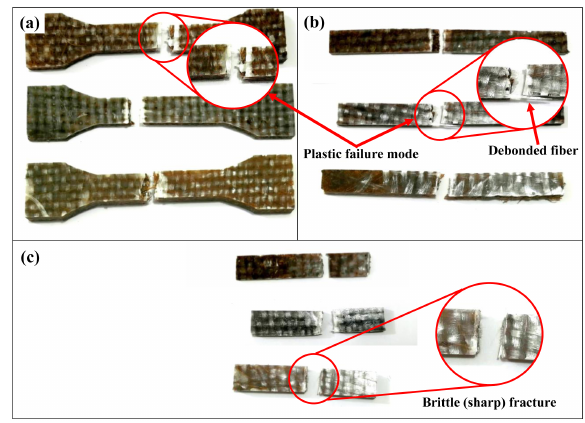
Fig. 10. Fractured specimens after testing (a) tensile strength, (b) flexural strength, and (c) impact